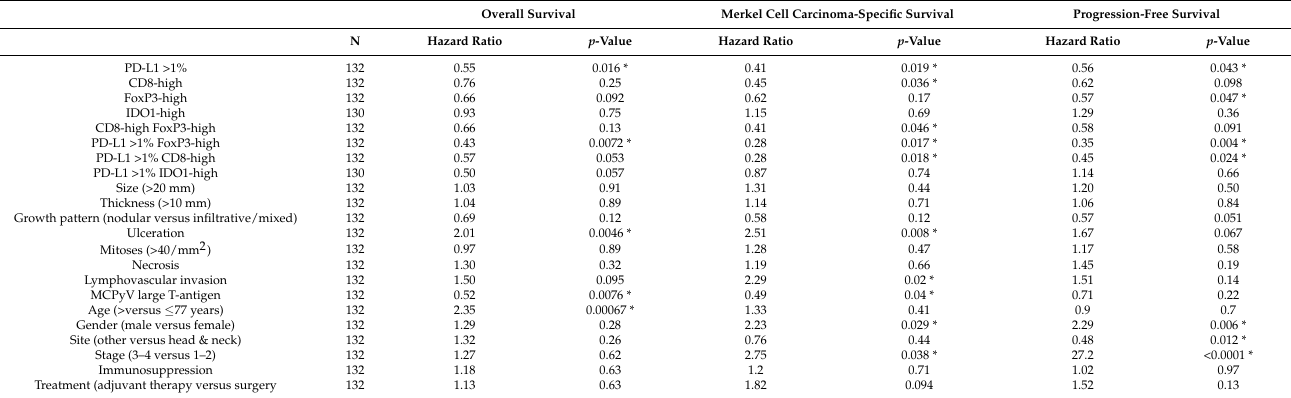
Table 2. Univariate Cox proportional hazards model.